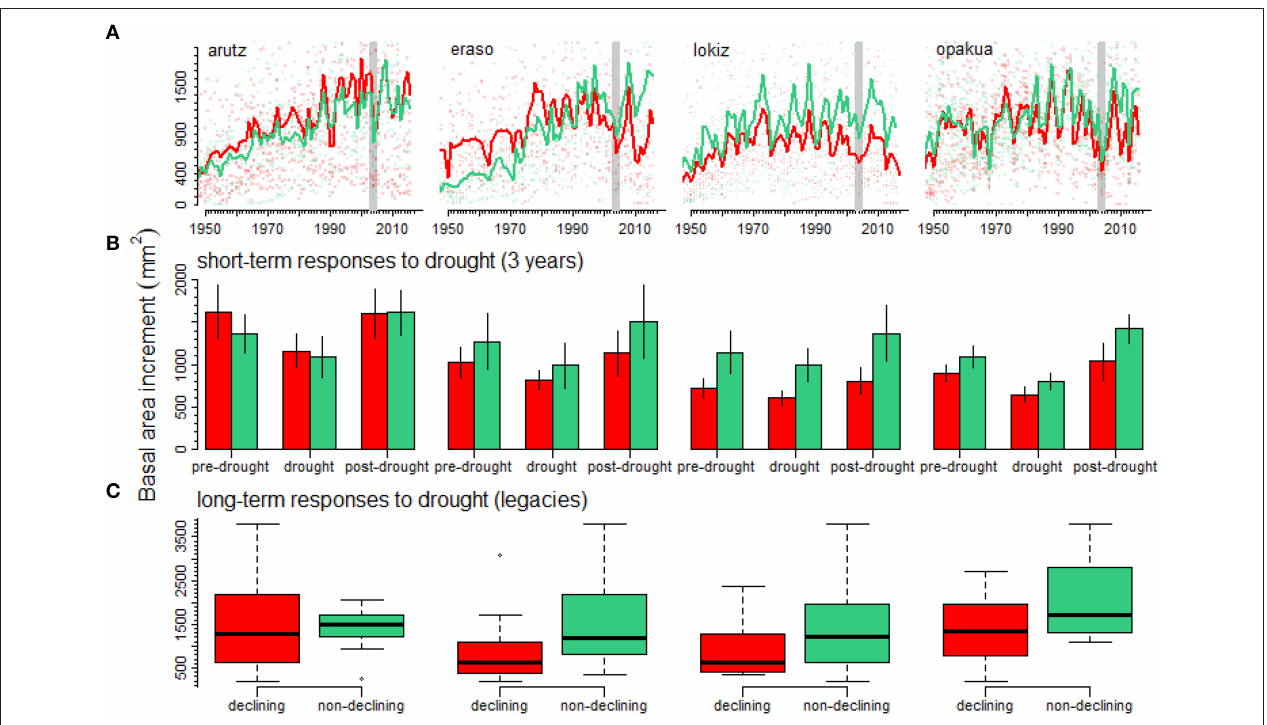
FIGURE 3 | Declining (red lines, symbols and bars) and non-declining (green lines, symbols and bars) beech individuals show different growth responses (A) to drought at short- (B) and long-term (C) scales. Basal area increments are shown for four beech forests (A) separating declining and non-declining individuals. Vertical bars indicate the 2003–2005 drought characterized by warm temperatures and dry conditions that limited beech growth. The short-term response to drought (B) was studied by considering BAI for the three years previous and subsequent to the 2003–2005 drought. The legacy effects of drought on declining and non-declining beech individuals (C) were studied considering the average BAI for the period 2006–2017 following the 2003–2005